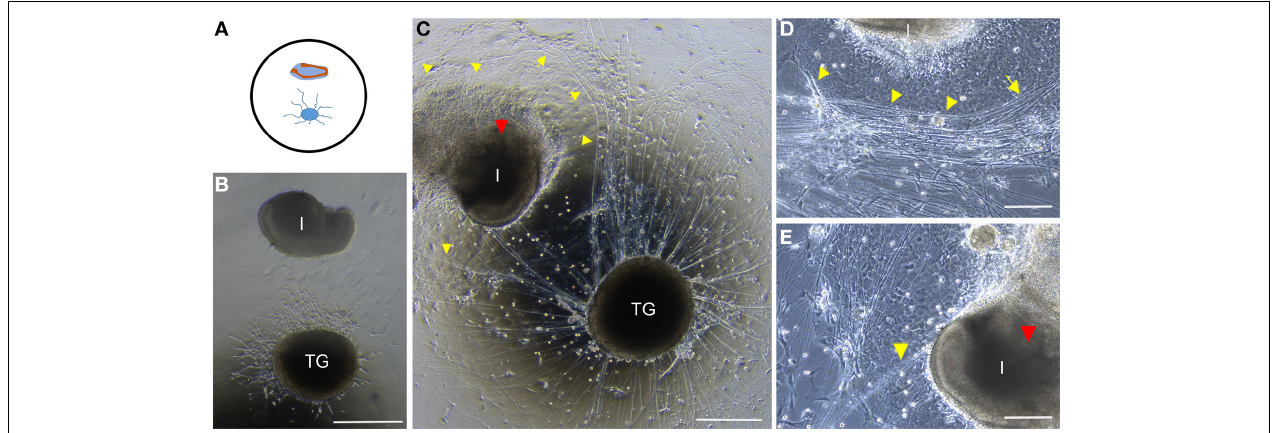
FIGURE 2 | Conventional co-cultures of trigeminal ganglia (TG) and incisors. (A) Schematic representation of the disposition of embryonic trigeminal ganglion and incisor in co-culture on glass dishes. (B) Trigeminal ganglion (TG) and incisor (I) after 4 days in co-culture. (C) Trigeminal ganglion and incisor after 10 days in co-culture. Axons (yellow arrowheads) are clearly repealed by the incisor. The incisor presents